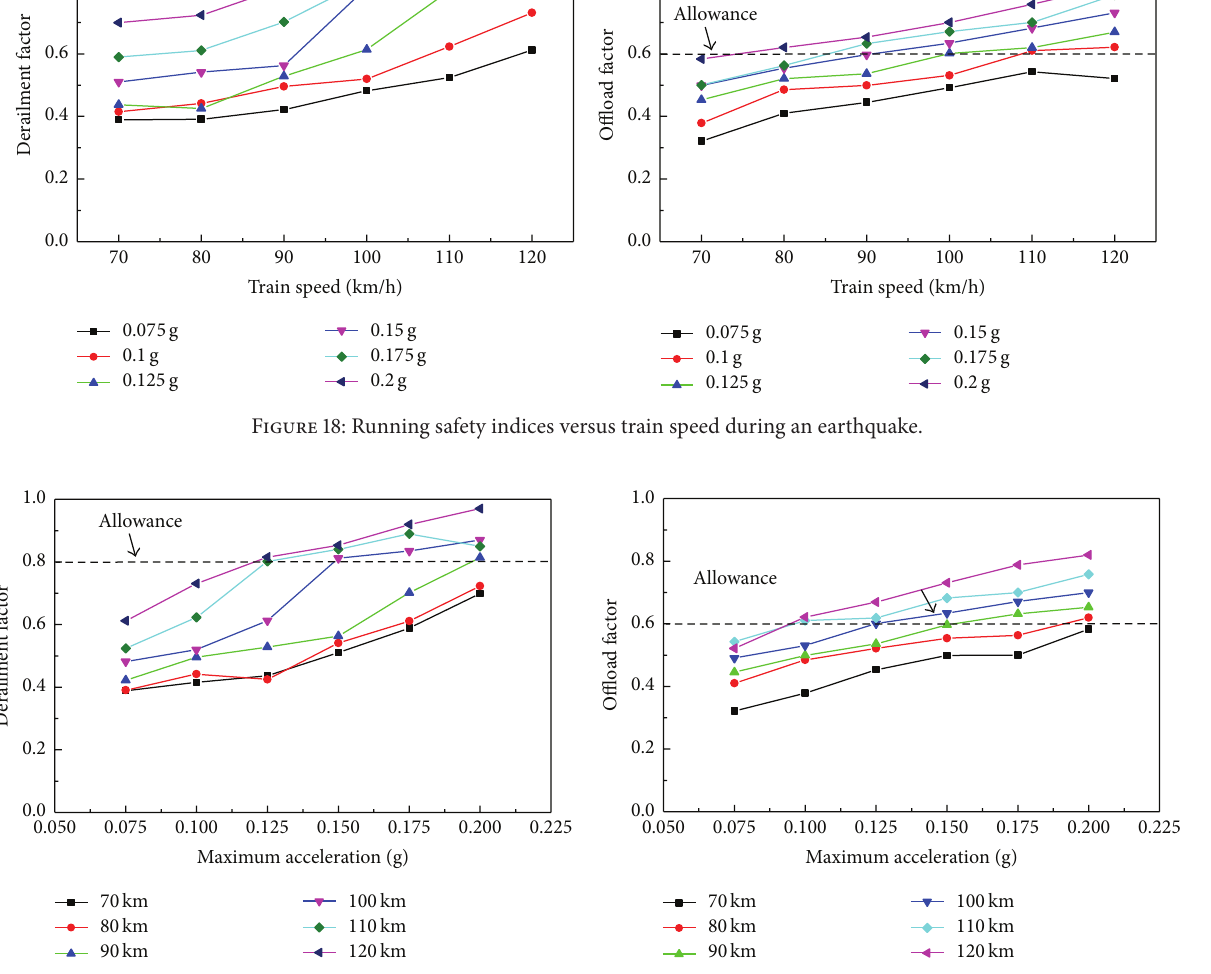
Figure 19: Running safety indices versus the peak ground